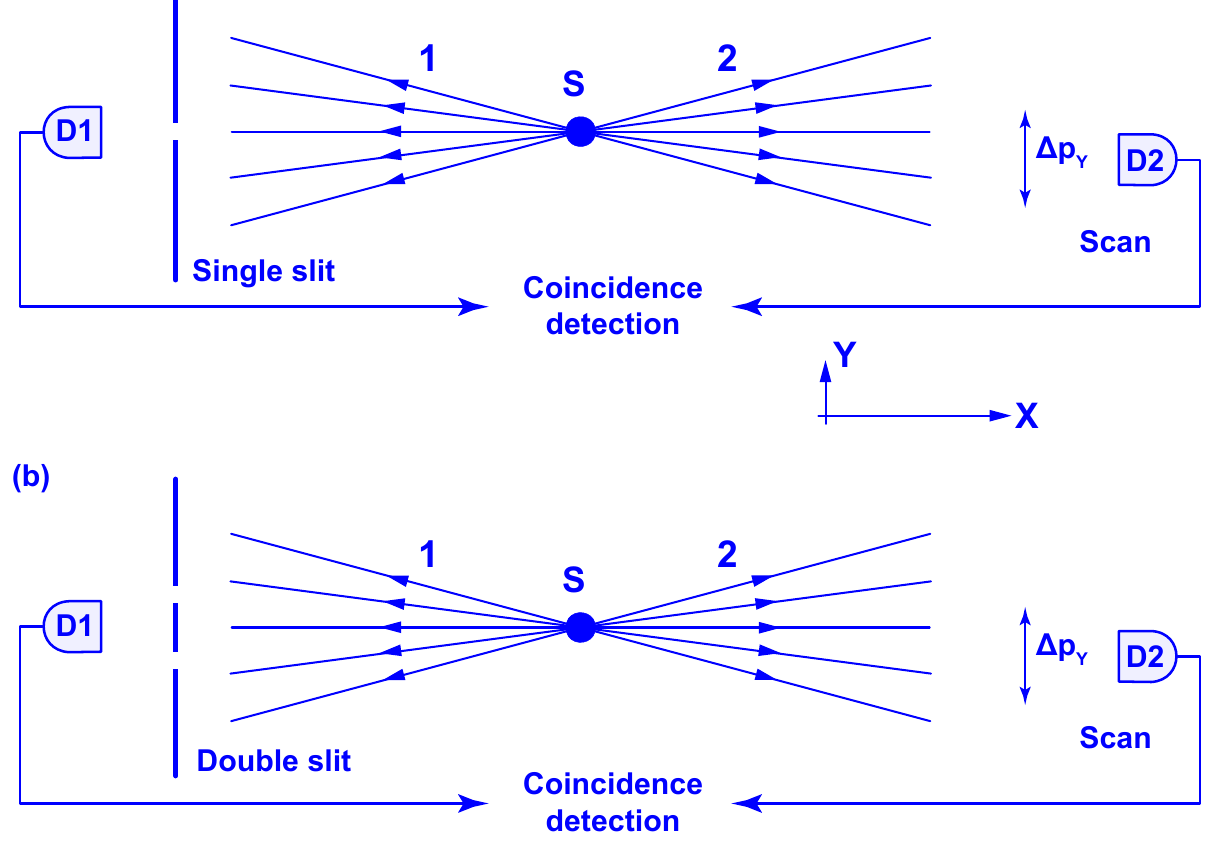
Figure 6: Schematic diagram of the Ghost di ff raction experiment [32]. Detector D1 behind the slit is fixed, and the detector D2 sweeps up and down to capture photons. Detectors D1 and D2 count photons in coincidence. (a) Experiment with a single slit. (b) Experiment with a